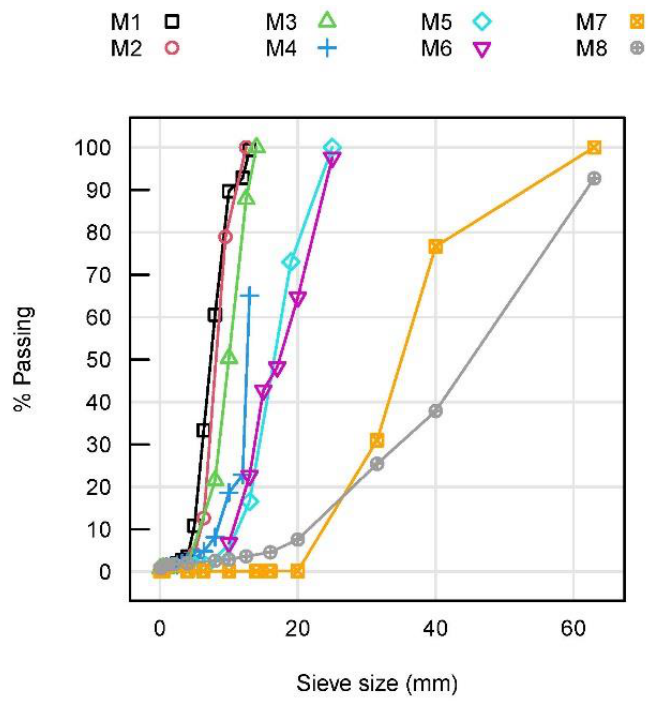
Figure 3. Particle size distribution of gravels from M1 to M8 .